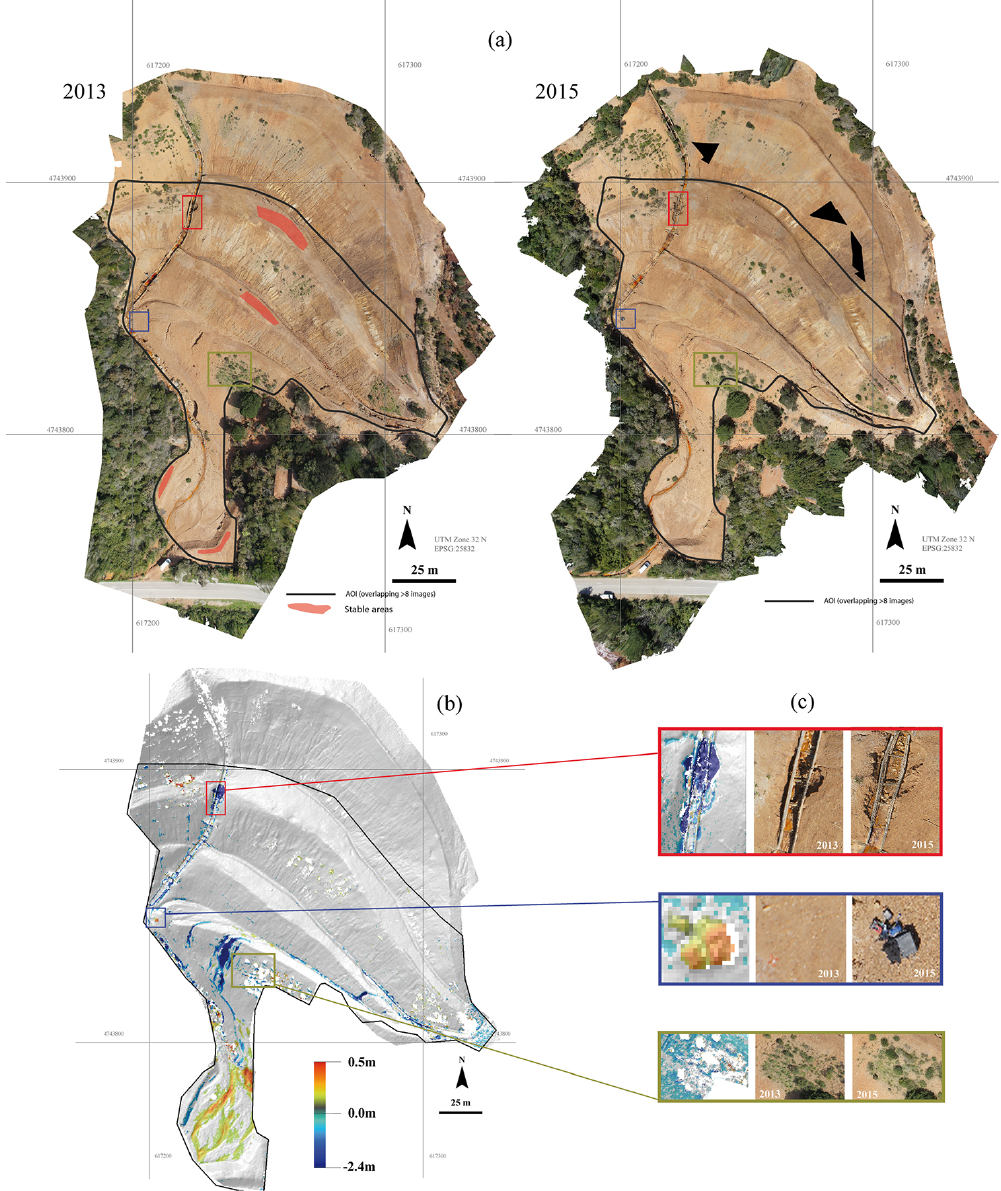
Figure 10. (a) Aerial photographs of the 2013 and 2015 UAV epochs with the AoI and the stable areas used for error estimation, (b) the surface changes for the period 2013–2015 for the AoI, and (c) enlargements of special